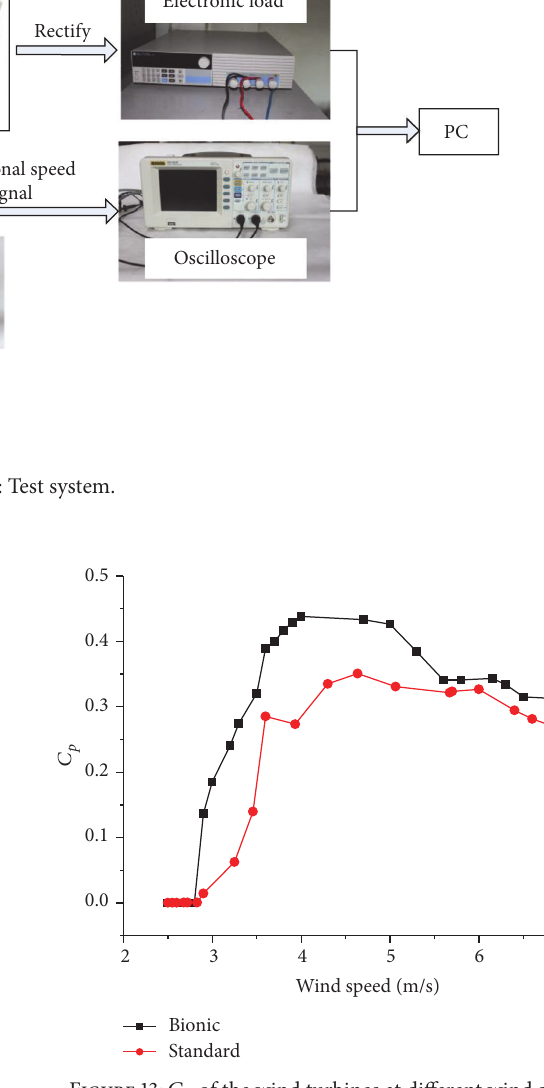
Figure 12: Relationships between power and wind speeds. Figure 13: 𝐶 𝑝 of the wind turbines at different wind